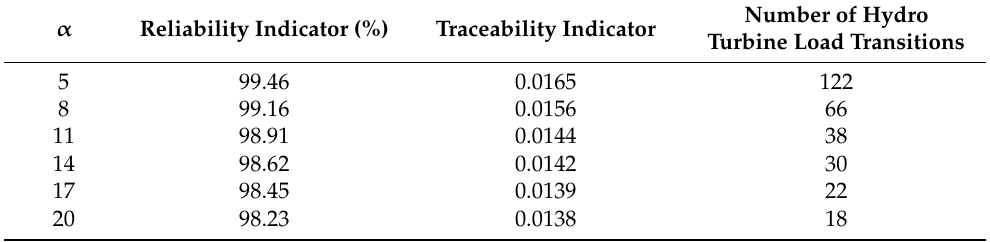
Table 4. Evaluation results of system output under some α values on a typical winter